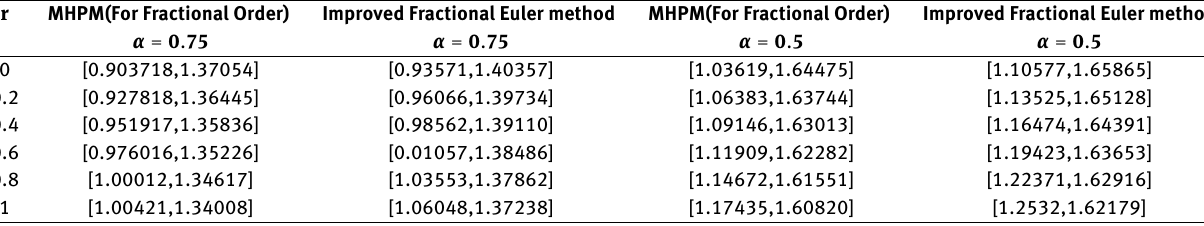
Table 4. Solutions obtained by MHPM and IFEM for h = 0.01 at t = 0.1 For different values of α . r MHPM(For Fractional Order)